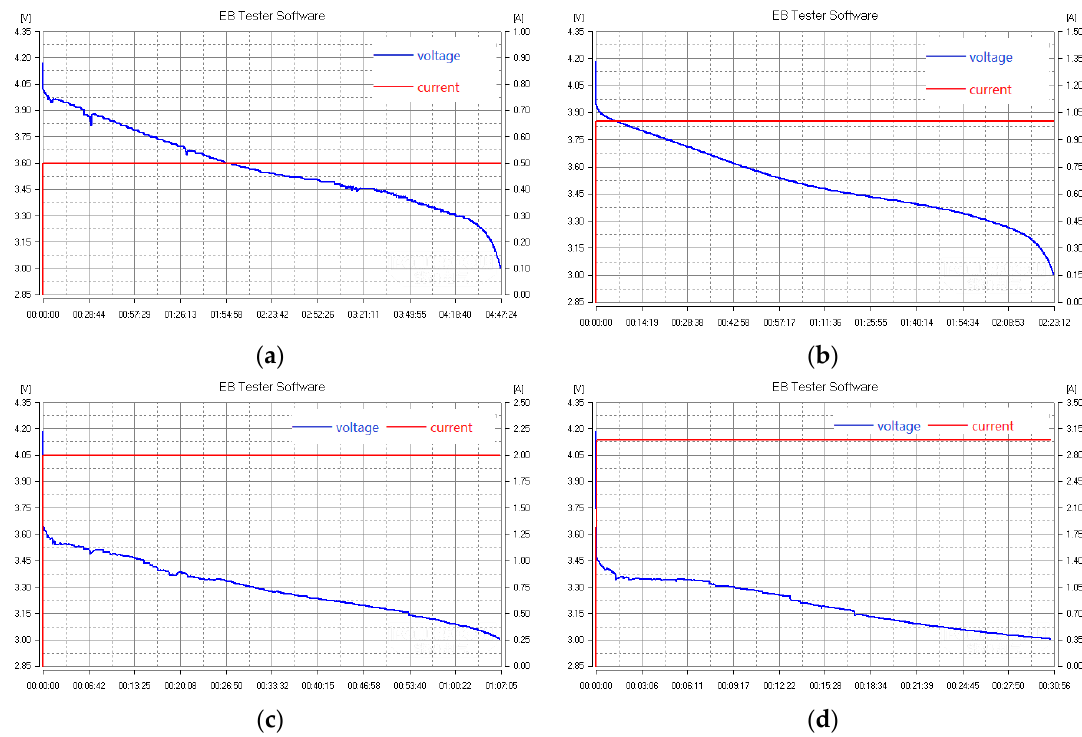
Figure 3. Voltage curve of the battery under different discharge currents. The discharge currents are 0.5A ( a ), 1A ( b ), 2A ( c ) and 3A ( d ), respectively.